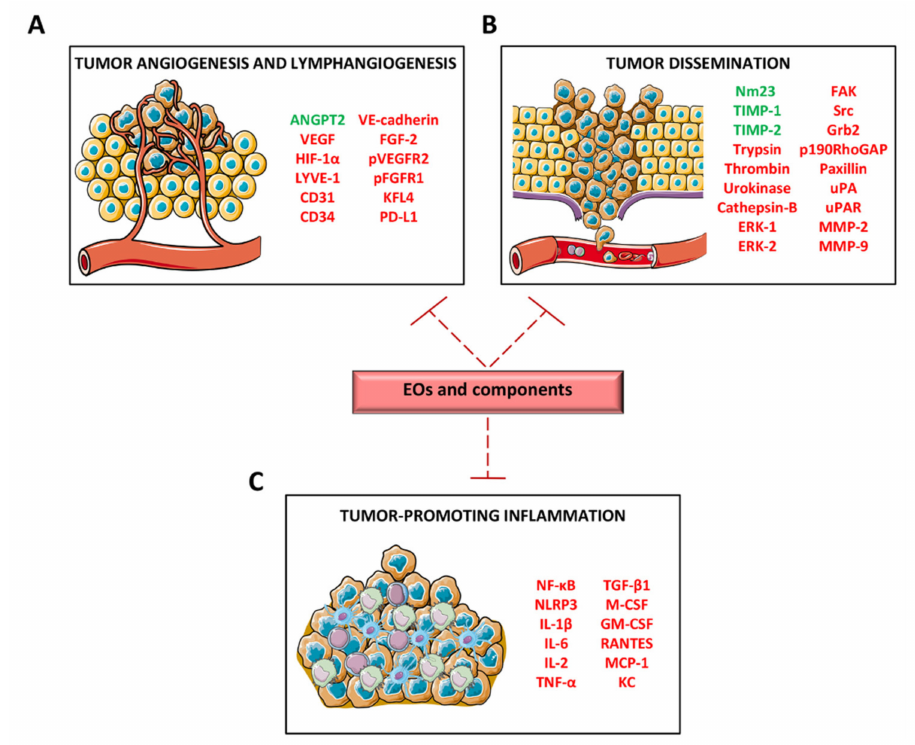
Figure 1. EOs and their components reduce tumor angiogenesis, lymphangiogenesis ( A ) and tumor metastasization, by targeting proteins responsible for tumor dissemination ( B ) and tumor-promoting inflammation ( C ). Angiopoietin 2 (ANGPT2), vascular endothelial growth factor (VEGF), hypoxia responsive factor 1 α (HIF-1 α ), lymphatic vessel endothelial receptor (LYVE-1), cluster of di ff erentiation 31 (CD31), cluster of di ff erentiation 34 (CD34), vascular endothelial cadherin (VE-cadherin), fibroblast growth factor 2 (FGF-2), phospho vascular endothelial growth factor receptor 2 (pVEGFR2), phospho fibroblast growth factor receptor-1 (pFGFR1), krüppel-like factor 4 (KFL4), programmed death-ligand 1 (PD-L1), tissue inhibitor of metalloproteinase-1 (TIMP-1) and -2 (TIMP-2), extracellular signal-regulated kinase-1 (ERK-1) and -2 (ERK-2), focal adhesion kinase (FAK), growth factor receptor-bound protein 2 (Grb2), urokinase-type plasminogen activator (uPA), uPA receptor (uPAR), metalloproteinases-2 (MMP-2) and -9 (MMP-9), nuclear factor kappa B (NF-kB), NLR family pyrin domain containing 3 (NLRP3), interleukin 1 β (IL-1 β ), interleukin 6 (IL-6), interleukin 2 (IL-2), tumor necrosis factor- α (TNF- α ), transforming growth factor β 1 (TGF- β 1), macrophage colony stimulating factor (M-CSF), granulocyte-macrophage colony stimulating factor (GM-CSF), monocyte chemoattractant protein-1 (MCP-1), keratinocyte chemoattractant (KC). Proteins that are upregulated by EOs or their components are reported in green, proteins that are downregulated by EOs or their components are reported in red. Parts of the figure are drawn using pictures from Servier Medical Art (https: //